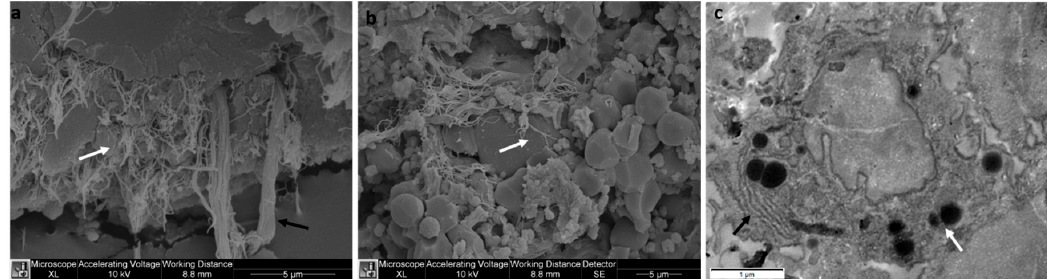
Figure 1. Representative SEM ( a ) and ( b ) and TEM ( c ) images of the Rigenera ® product obtained from the thigh. The Rigenera ® device provides fragments consisting of elastic fibers (( a ) black arrow), collagen fibers (( a ) and ( b ) white arrow), and different kinds of isolated cells ( b ), including mesenchymal-like cells ( c ), characterized by rough endoplasmic reticulum (black arrow) and lipidic droplets (white arrow). No differences at an ultrastructural level were found between the two sites of adipose tissue collection (thigh and abdomen).